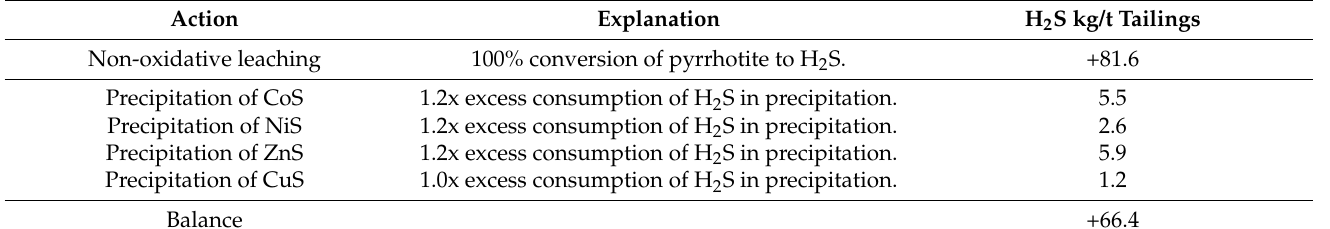
Table 6. H 2 S production and consumption balance in the plant utilising non-oxidative leaching of pyrrhotite, oxidative leaching of the residual solid and H 2 S precipitation of CoNiS, ZnS and CuS from